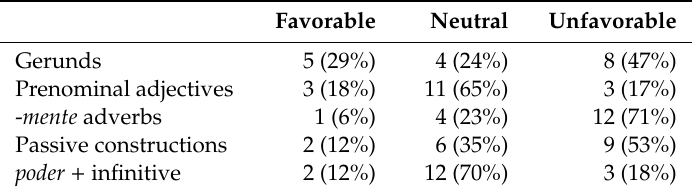
Table 4. Instructors’ responses on the attitudes they tend to display in the classroom ( N =